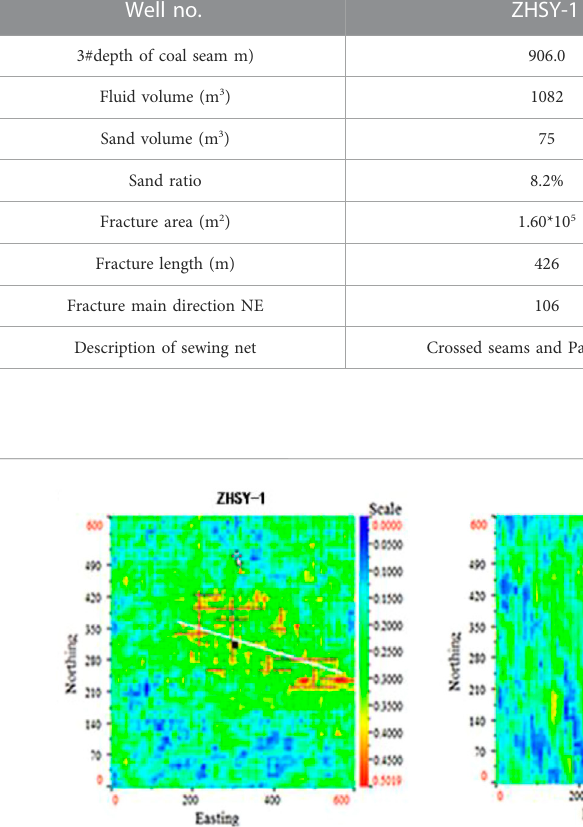
TABLE 3 Data of three wells and fracturing fractures. Well no.